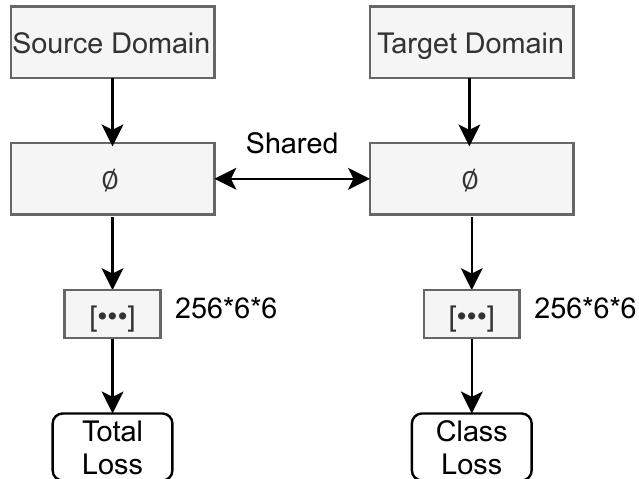
Figure 1. The architecture of Deep CORAL. φ denotes any deep neural network (e.g., AlexNet). The 256 * 6 * 6 denotes the size of the features maps extracted by AlexNet; the 256 stands for the number of channels, and 6 * 6 is the weight * height of a single feature